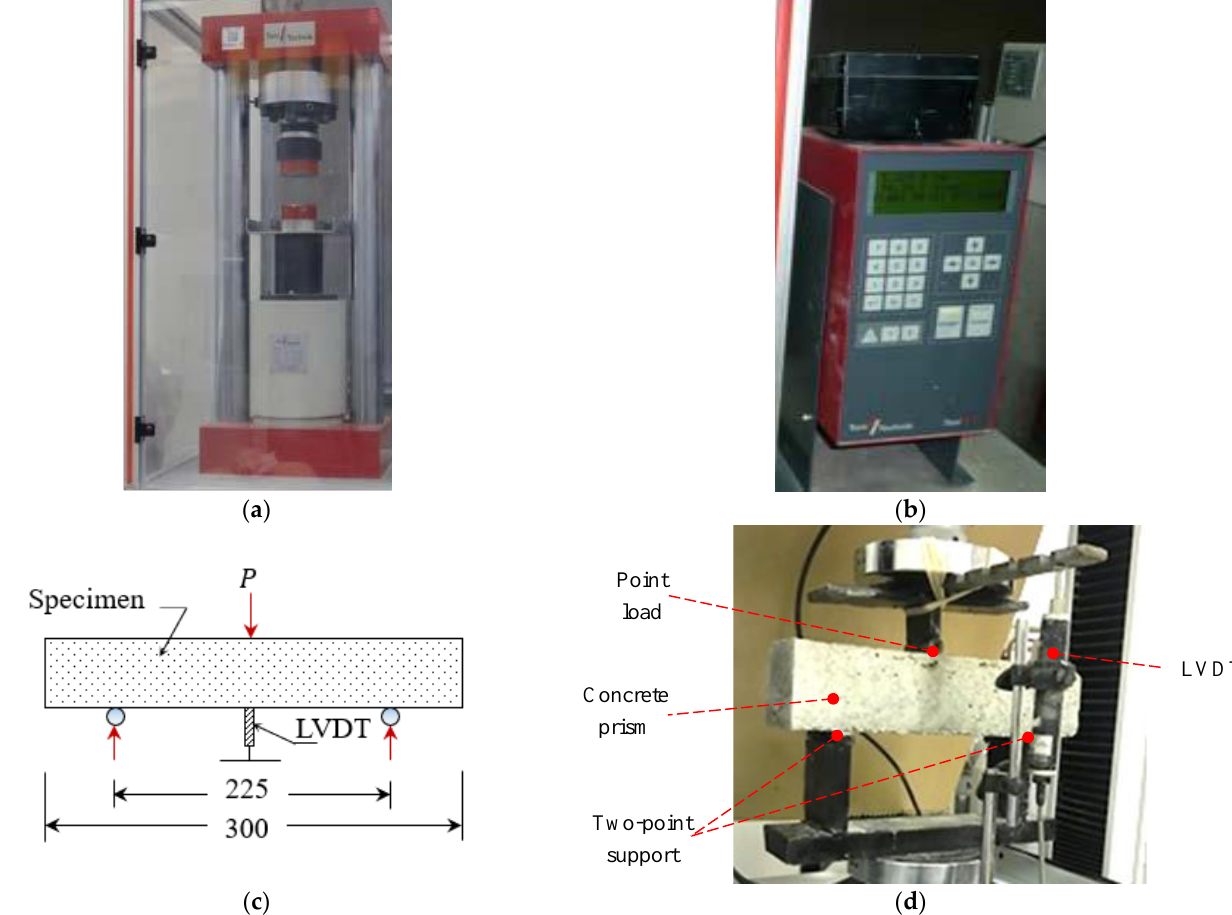
Figure 3. Compressive test ( a ) machine and ( b ) control unit. Flexural test ( c ) schematic diagram and ( d ) setup (dimensions are in mm).